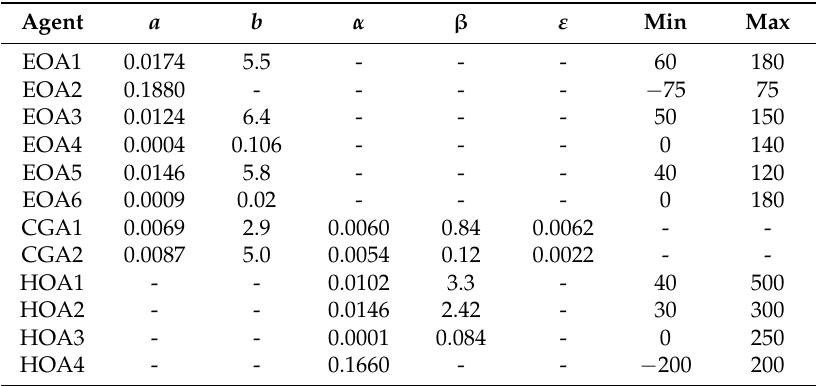
Figure 4. Feasible operating region of CGA1 and CGA2. Table 1. Parameters of the 16 ‐ bus system.